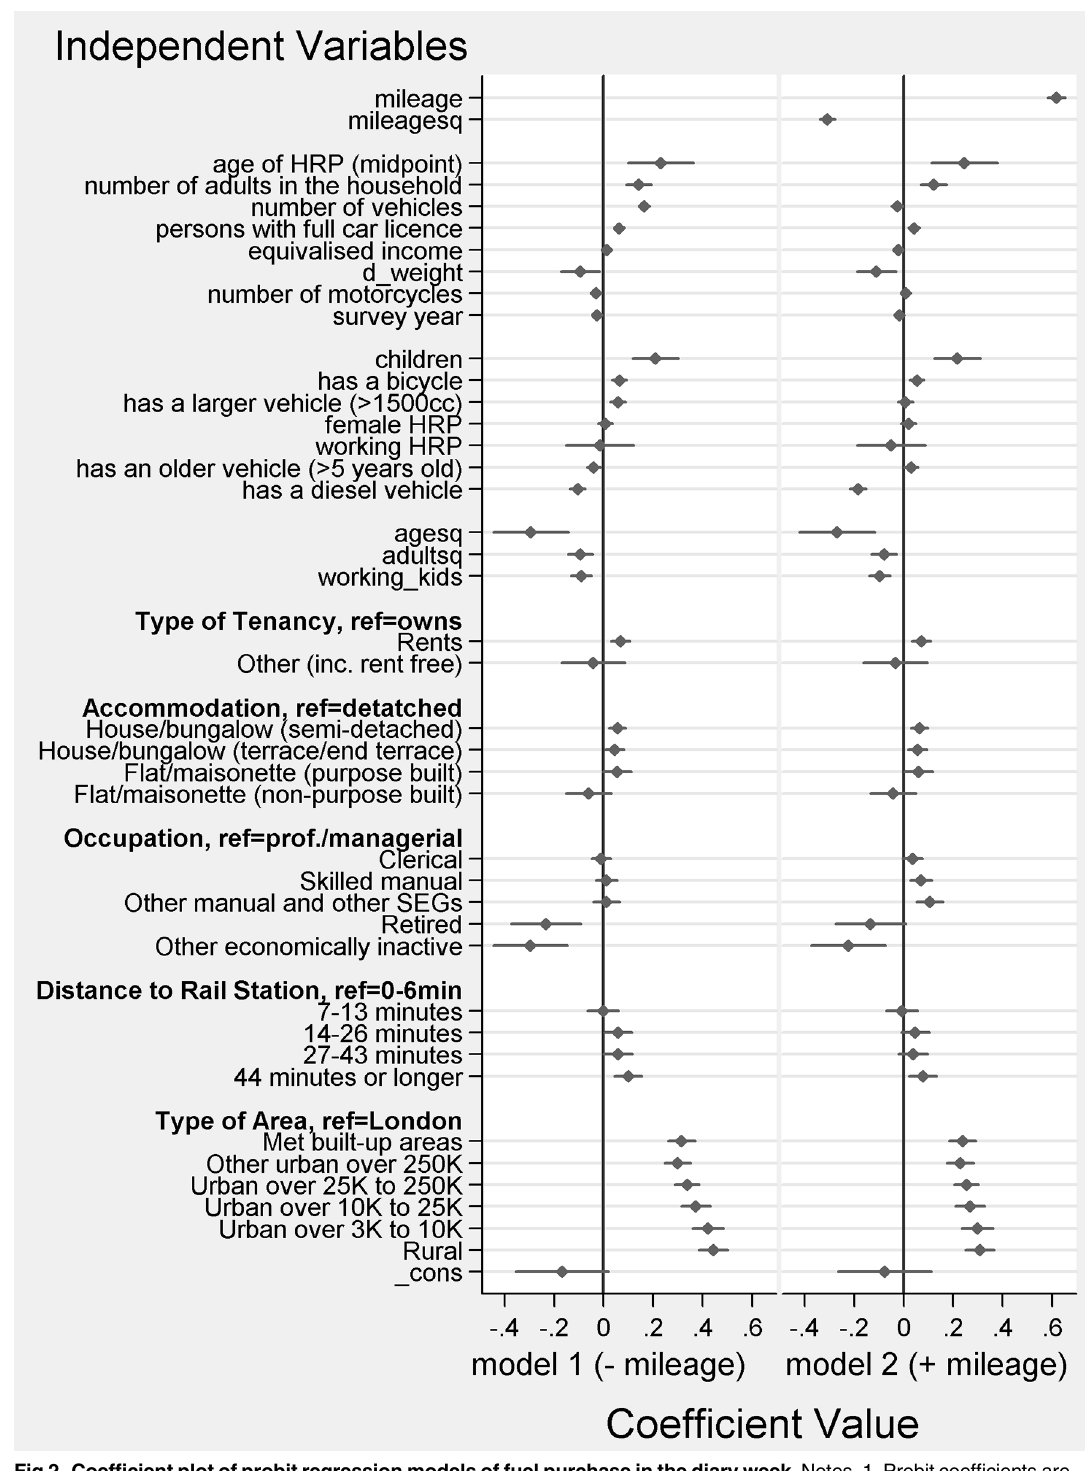
Fig 2. Coefficient plot of probit regression models of fuel purchase in the diary week. Notes. 1. Probit coefficients are shown as diamonds with lines representingconfidenceintervals. 2. Continuous regressors are standardised to have mean zero and unit variance.3. Household-level variables are derived from individual- and vehicle-level data (authors’ calculations). 4. A dummy for each top-coded variableis includedin the estimationsbut not shown. 5. For model 1 McFadden’spseudo r-sq (adjusted)= 0.053, count r-sq (adjusted)= 0.11 and Log-L = -27250.28. Model 2 has 2 additionalparameters; McFadden’s